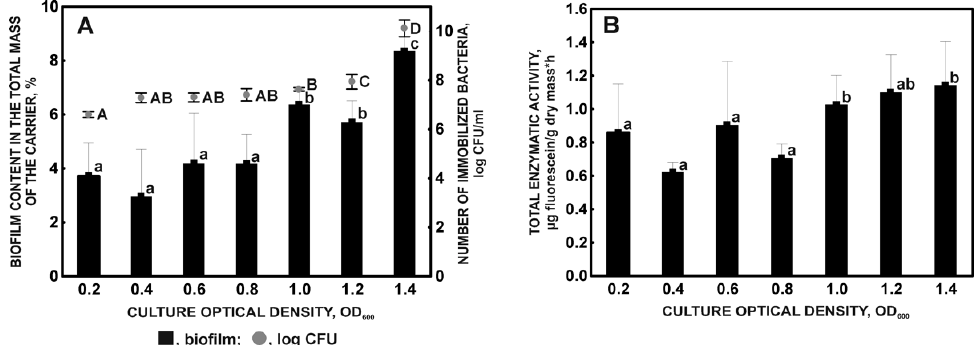
Figure 3. Biofilm content in the total mass of the sponge and the number of immobilized bacteria ( A ), and the total enzymatic activity of the immobilized microorganisms ( B ) in relation to the culture optical density after 72 incubation hours. Different letters indicate the existence of statistically significant differences (ANOVA, p < 0.05).